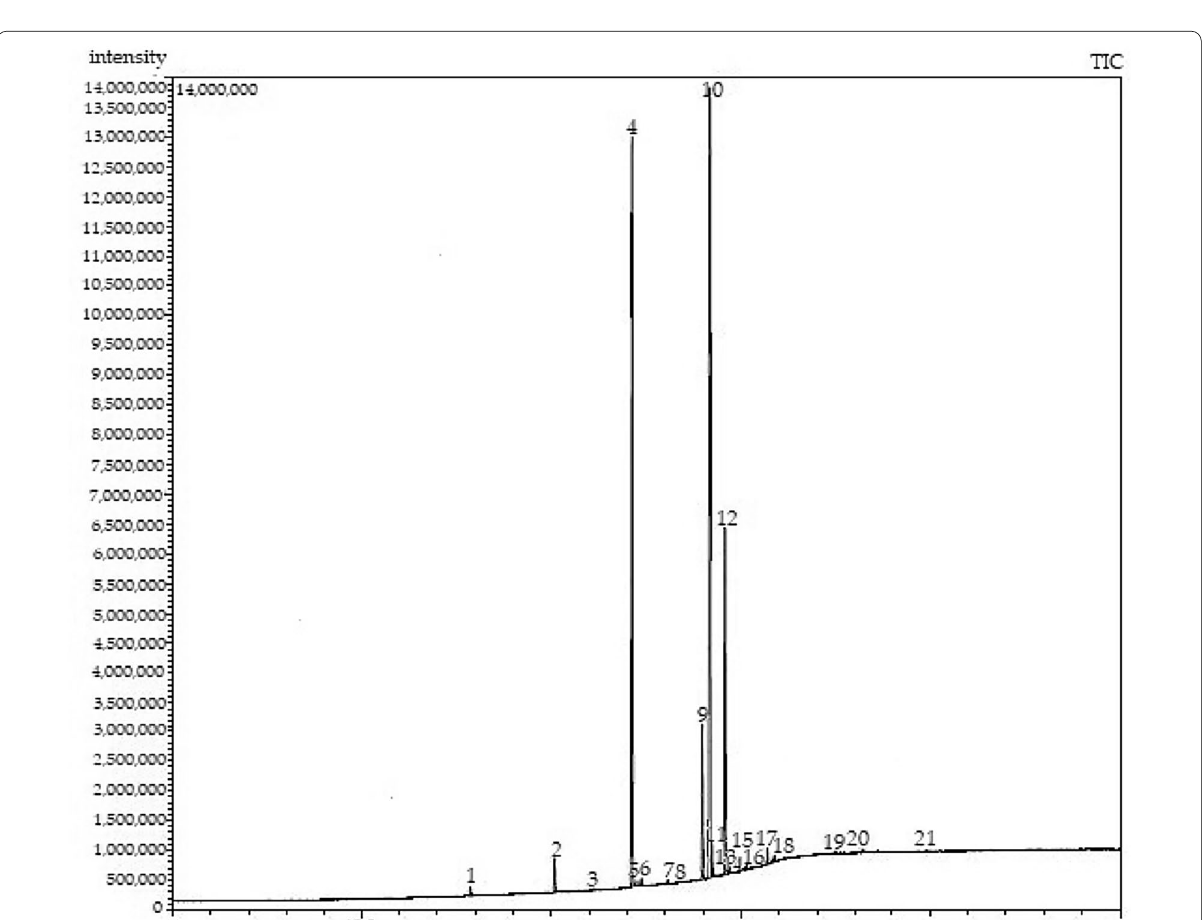
Fig. 4 GC–MS chromatogram of crude